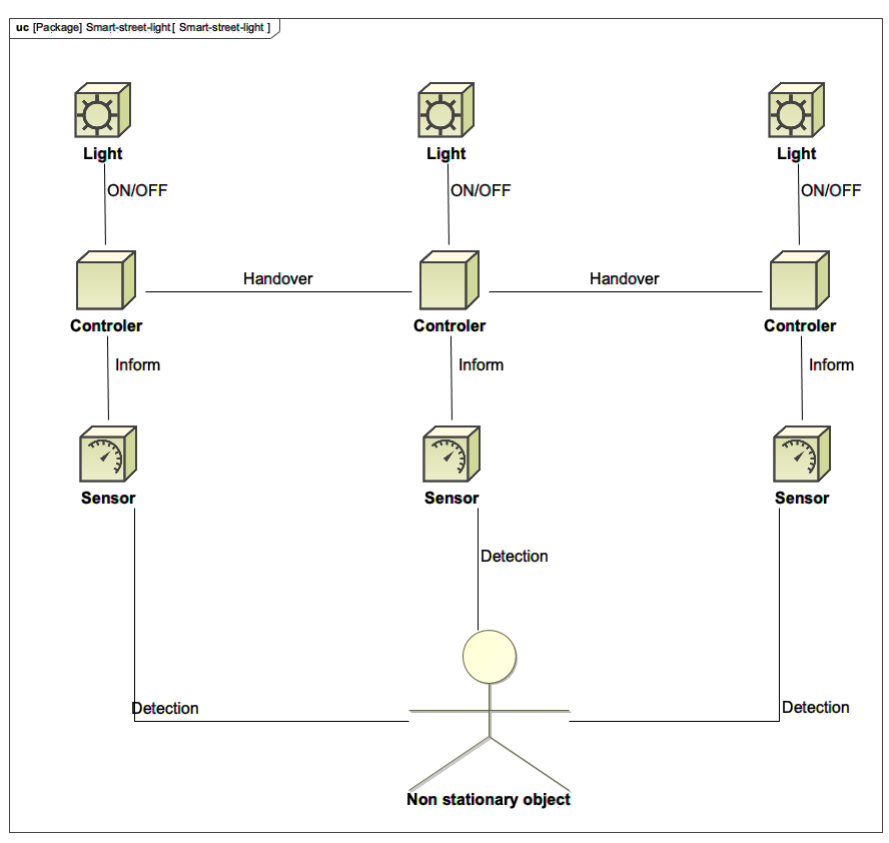
Figure 5. A SysML use case diagram for the smart streetlight use case.